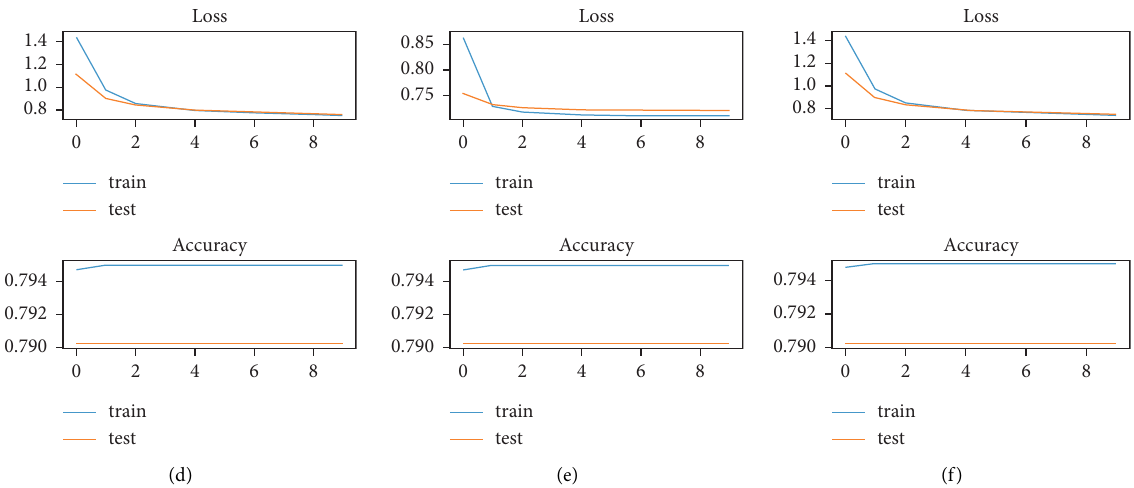
Figure 3: Impact of different hyperparameters on the performance of DNN. (a) Epochs and batch_size. (b) Optimization algorithms. (c) Learning rate and momentum. (d) Weight initialization. (e) Activation function. (f) Dropout